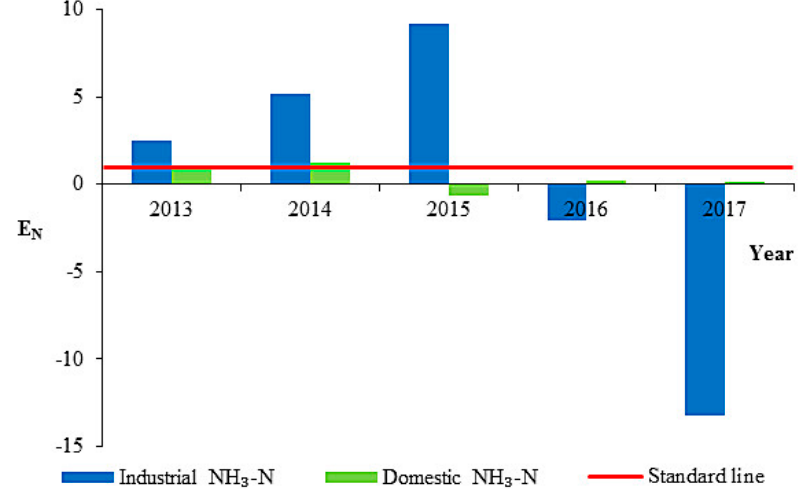
Figure 10. The elasticity coefficients between industrial (or domestic) NH 3 -N emissions and wastewater